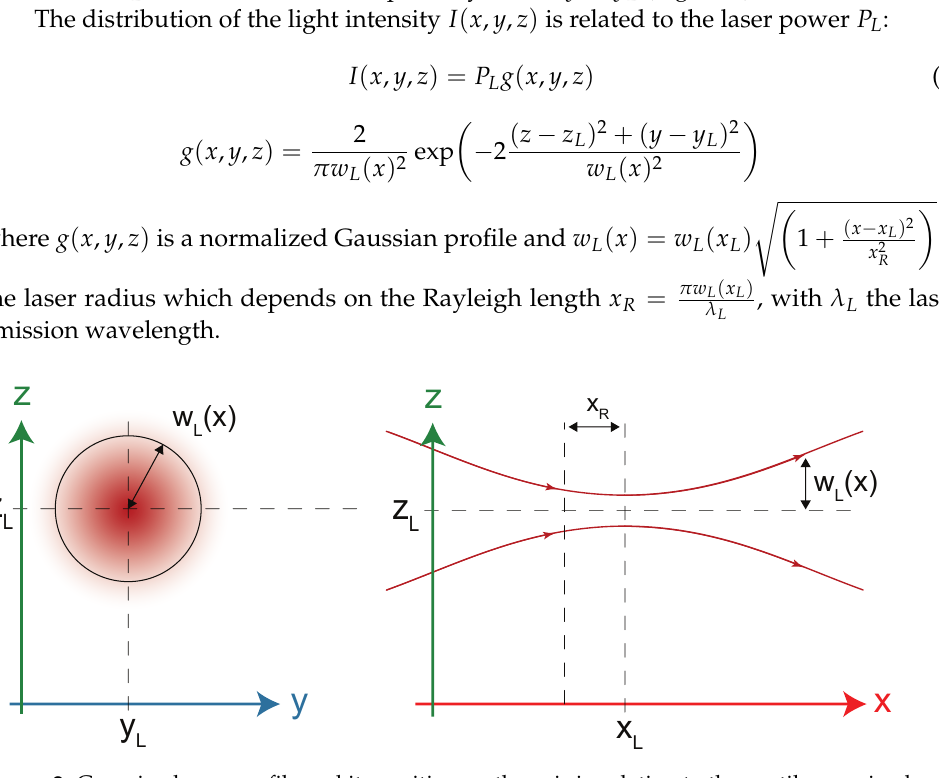
Figure 2. Gaussian beam profile and its position on the axis in relation to the cantilever microbeam. w L ( x L ) = 100 µ m, λ L = 1.65 µ m, x L = 0.725L, y L = 0, z L = 150